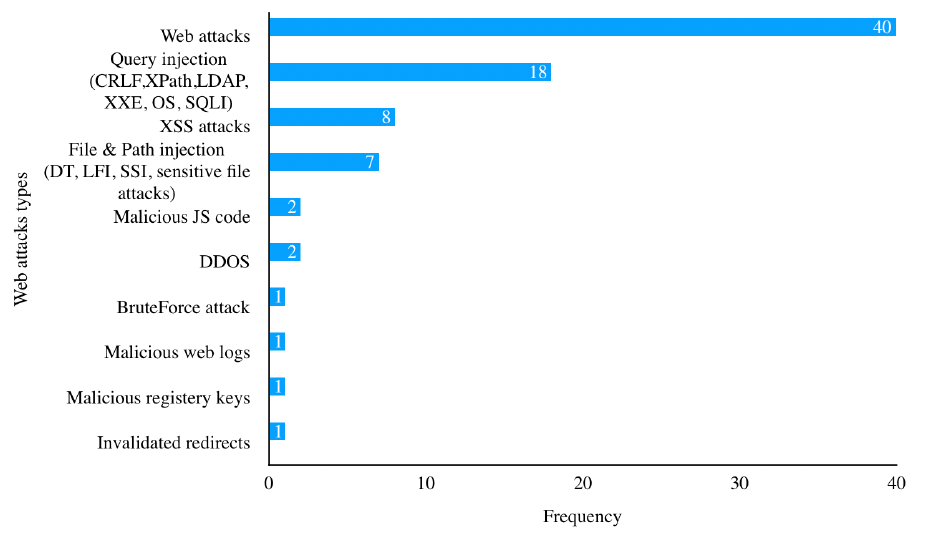
Figure 15. Histogram of web attacks types used in the selected PS.